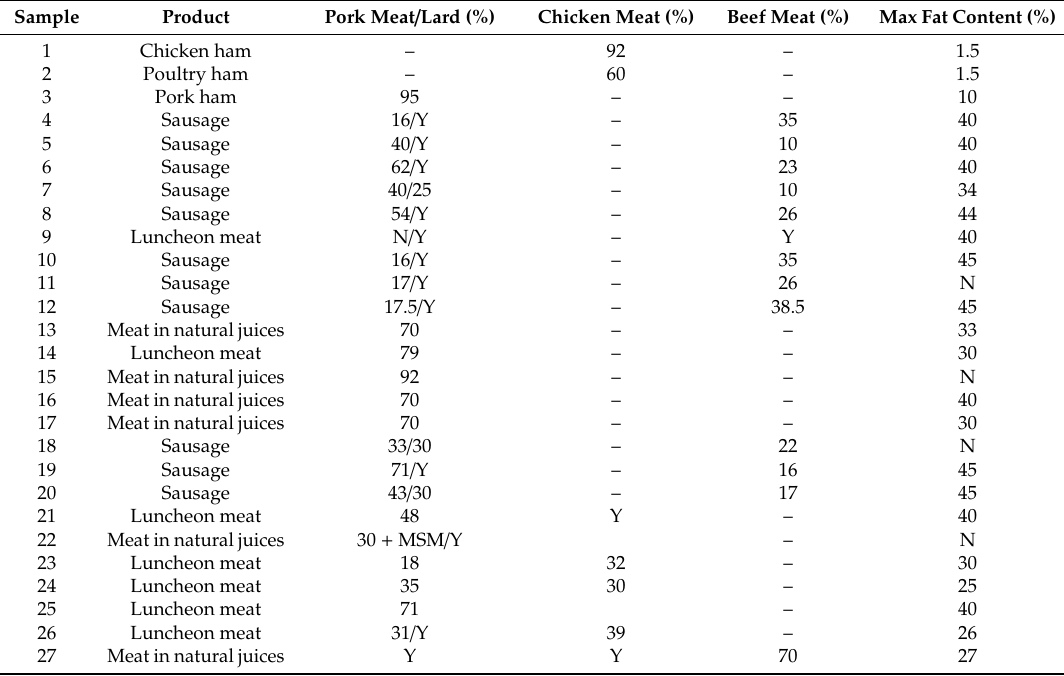
Table 1. Declared composition of analyzed